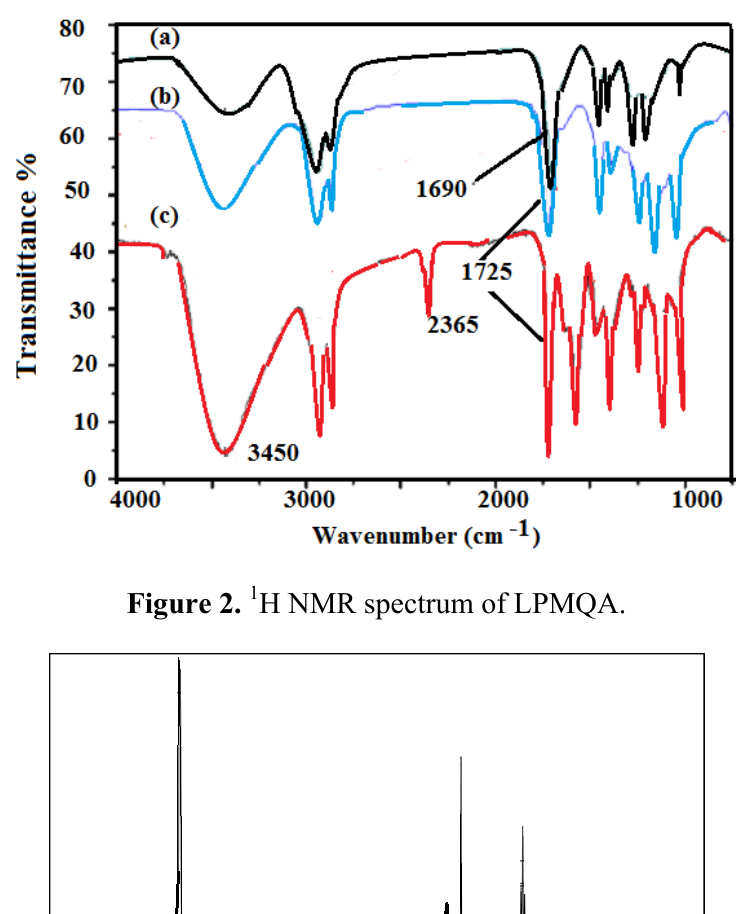
Figure 1. FTIR spectra of: (a) rosin AbA; (b) LPME; (c) LPMQA.